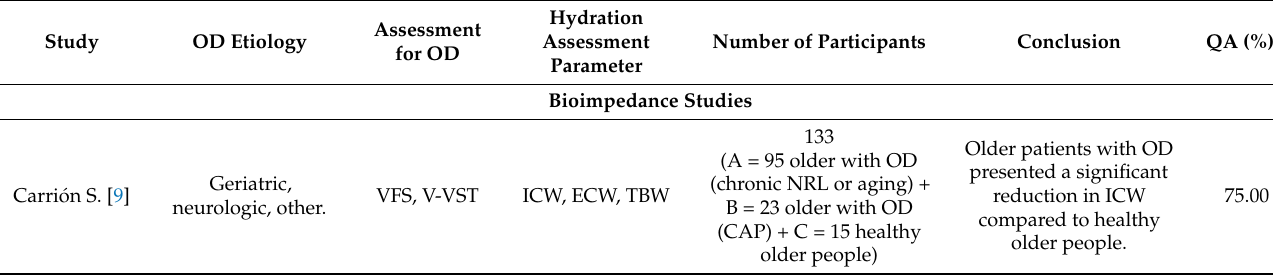
Table 1. Main results on hydration status in Systematic Review